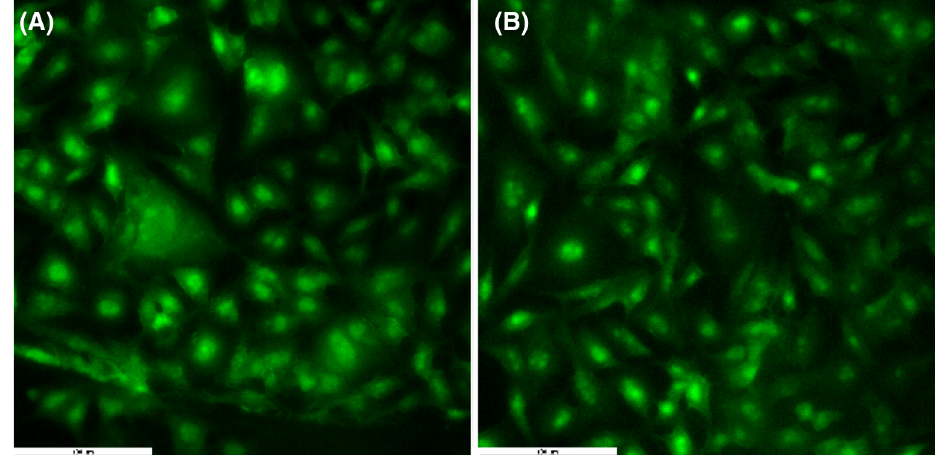
Figure 1. Fluorescence microscopy images of B16 cells grown 48 h on ( A ) biocompatible glass and ( B ) gold surface; scale bars: 100